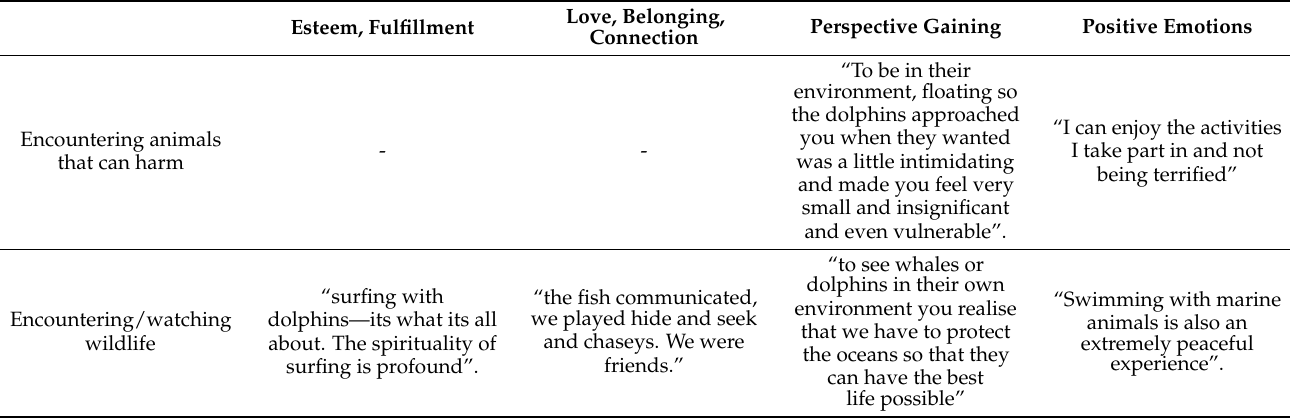
Table 4. Overlaps between IPS and